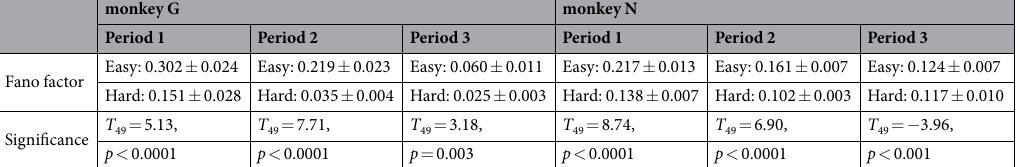
Table 1. Comparison of the amplitudes of the Fano factors between the easy (first two rows) and hard (second two rows) tasks during Periods 1, 2 and 3 for monkeys G (first three columns) and N (last three columns). Significant differences according to the paired t test are shown in the last two